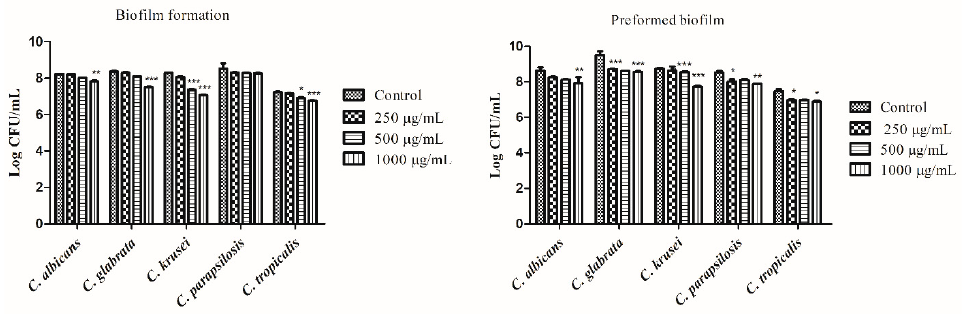
Figure 4. Effect of complex 1 [CuCl 2 (Bipy)(L 1 )] during biofilm formation and on preformed biofilms of Candida species. * p <0.05; ** p <0.01; *** p <0.001 (ANOVA).